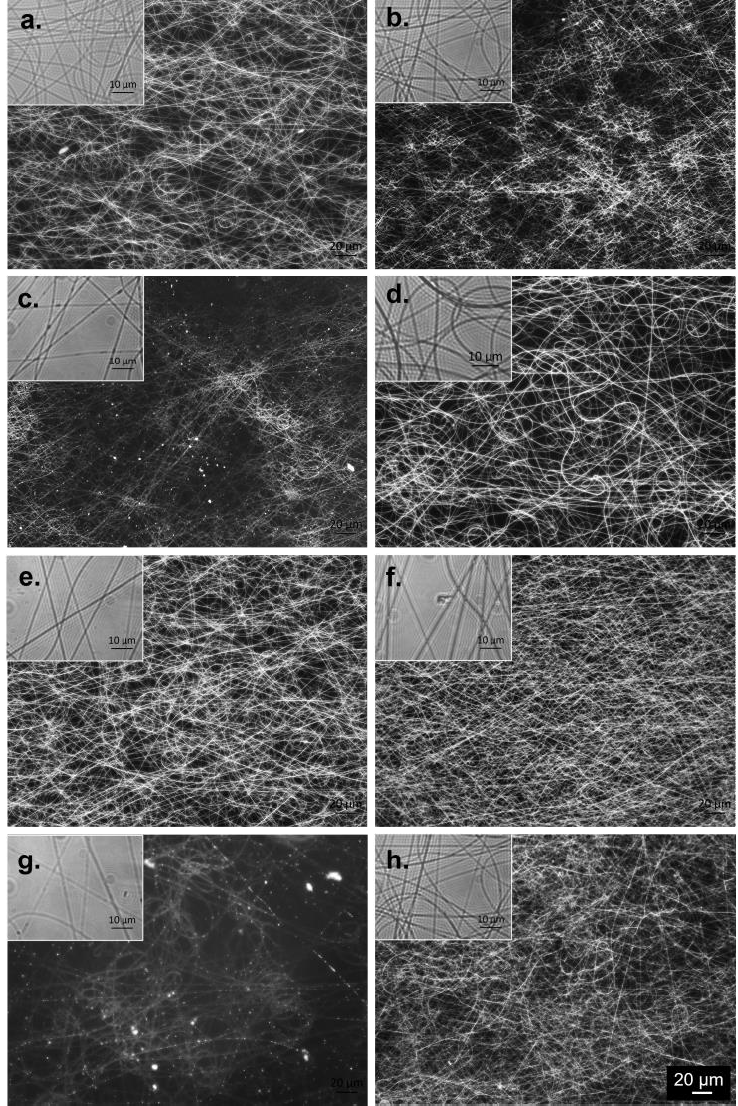
Figure 1. Representative optical microscopy images for the electrospun meshes: ( a ) FG, ( b ) FG_GO 0.5%, ( c ) FG_GO_1%, ( d ) FG_MNP 0.5%, ( e ) FG_MNP 1%, ( f ) FG_MNP 2%, ( g ) FG_GO_MNP 0.5%, ( h ) FG_GO_MNP 1%; general view 20× , scale bar 20 μm, the inset at the 100×-scale bar 10 μm.